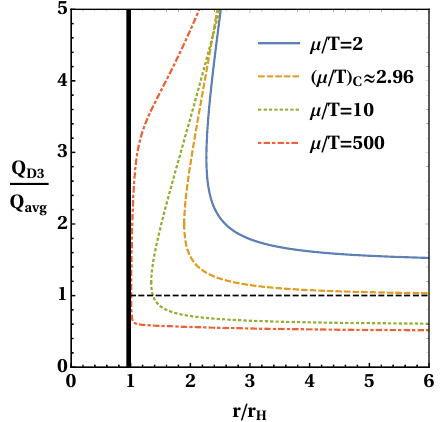
Figure 8 . The curves show the angular momentum where the e(cid:11)ective potential crosses zero as a function of radius, for backgrounds with k = 0 and all charges equal. Each curve is at a (cid:12)xed value of (cid:22)=T